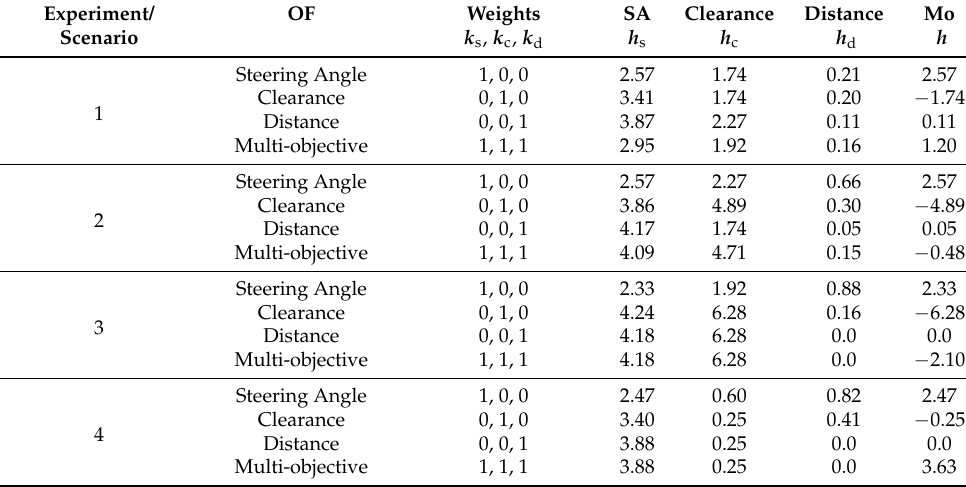
Table 1. Multi-objective functions with suitable weights.